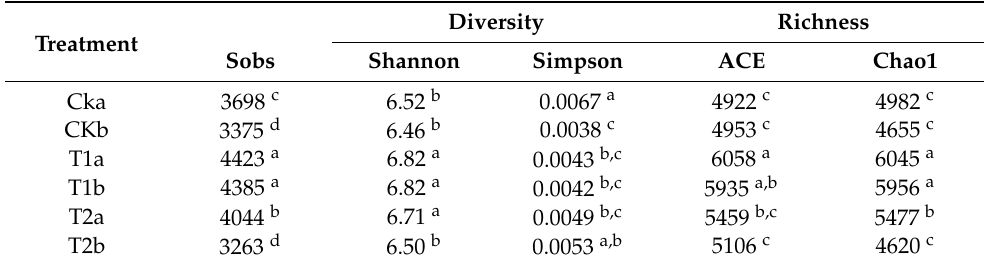
Table 3. Alpha diversity estimates of bacterial community at soil depth of 0–20 cm (a) and 20–40 cm (b) of three treatments in